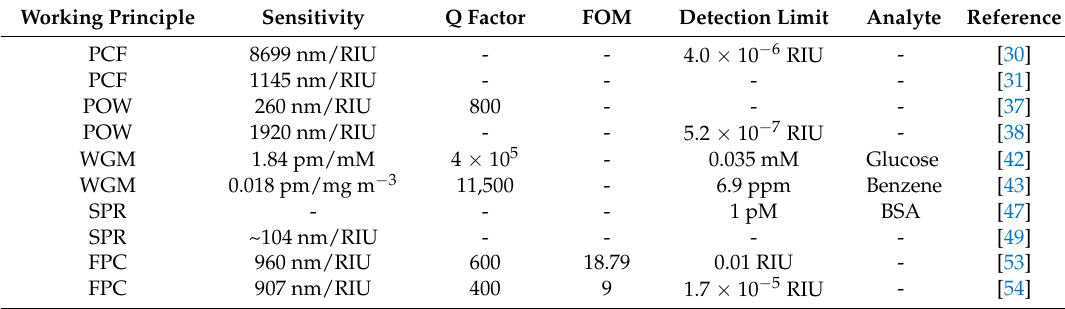
Table 1. Critical parameters of the refractive index (RI) sensors based on different